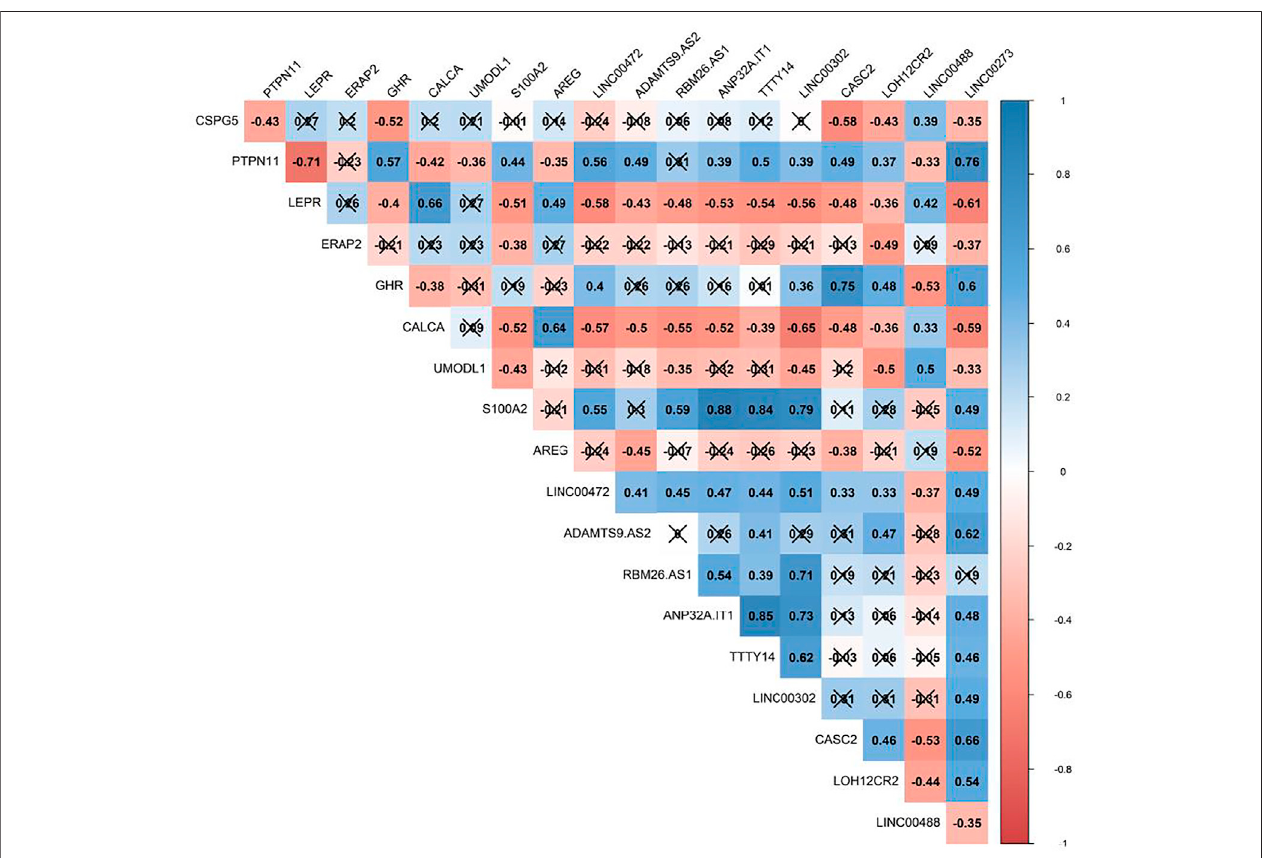
FIGURE 4 | Pearson correlation analysis between immune-related differentially expressed mRNAs (DEmRNAs) and lncRNAs (DElncRNAs). The blue and red representthepositiveandnegativecorrelations,respectively.Theintensityofthecolorsisrelatedtocorrelationcoef fi cients,andtheoneswitha p -valuegreaterthan0.01 are considered insigni fi cant. In this case, crosses are